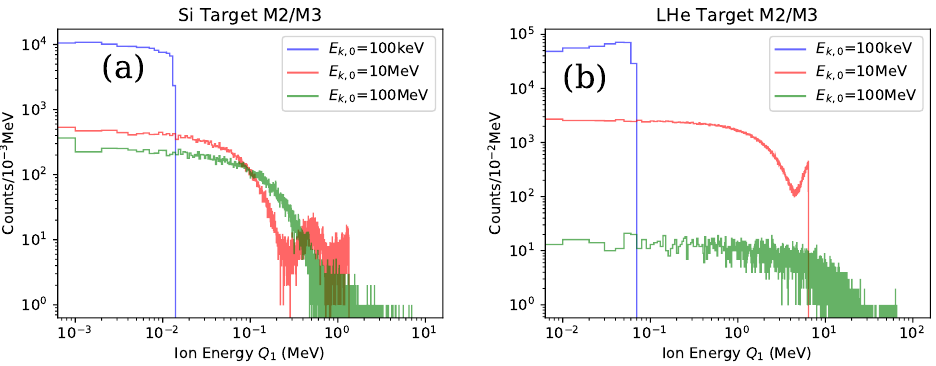
Figure 8. The energy distribution of the ion with the momentum Q 1 in ( a ) the silicon target and ( b ) in the liquid helium